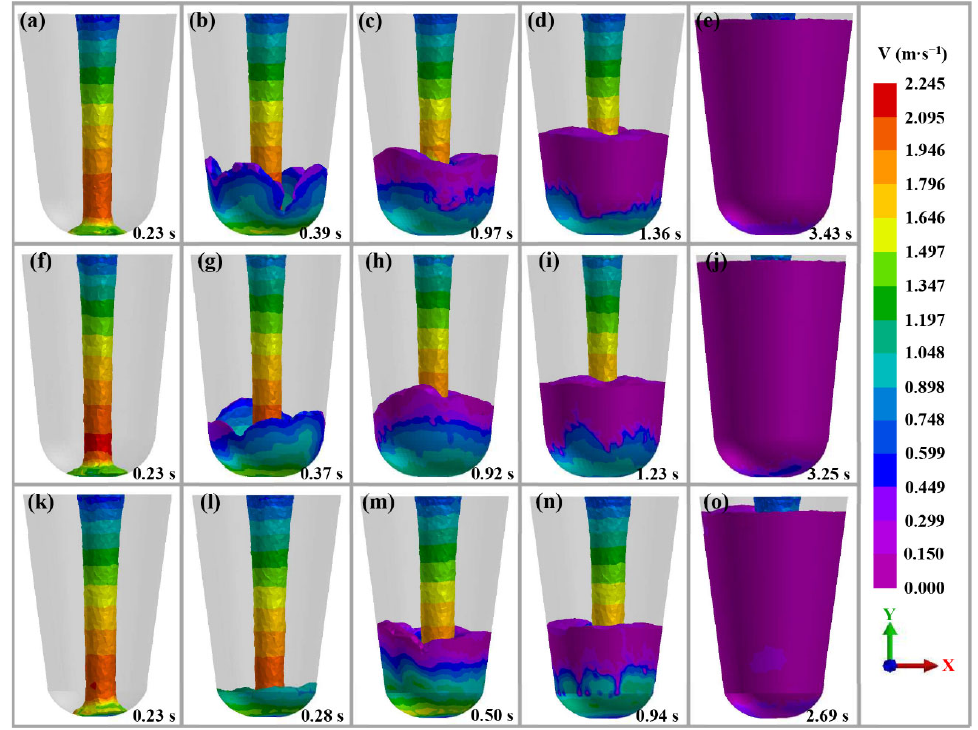
Figure 5. The fluid velocity of Ti ‐ 6Al ‐ 4V alloy in mold II ( a – e ), III ( f – j ), and IV ( k – o ).